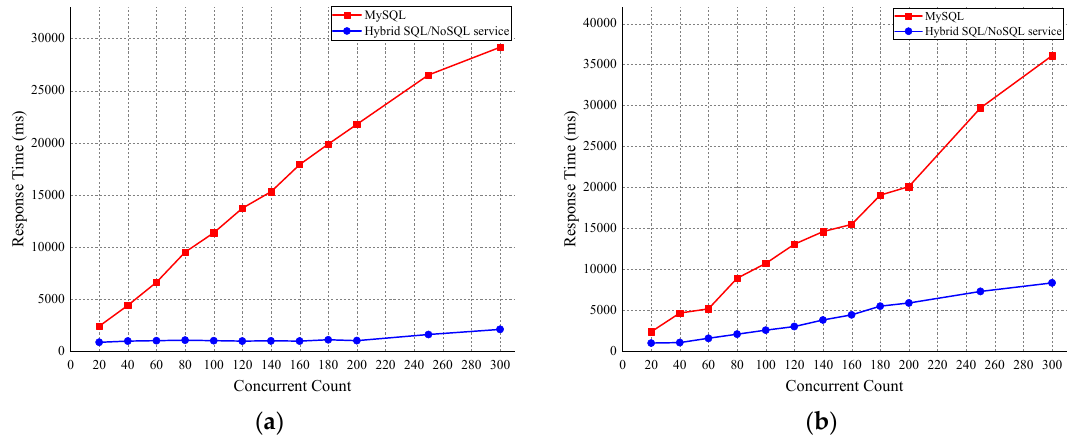
Figure 13. Efficiency comparison of responses to concurrent requests: ( a ) data retrieval of numerical data; ( b ) data retrieval of numerical data and image files.